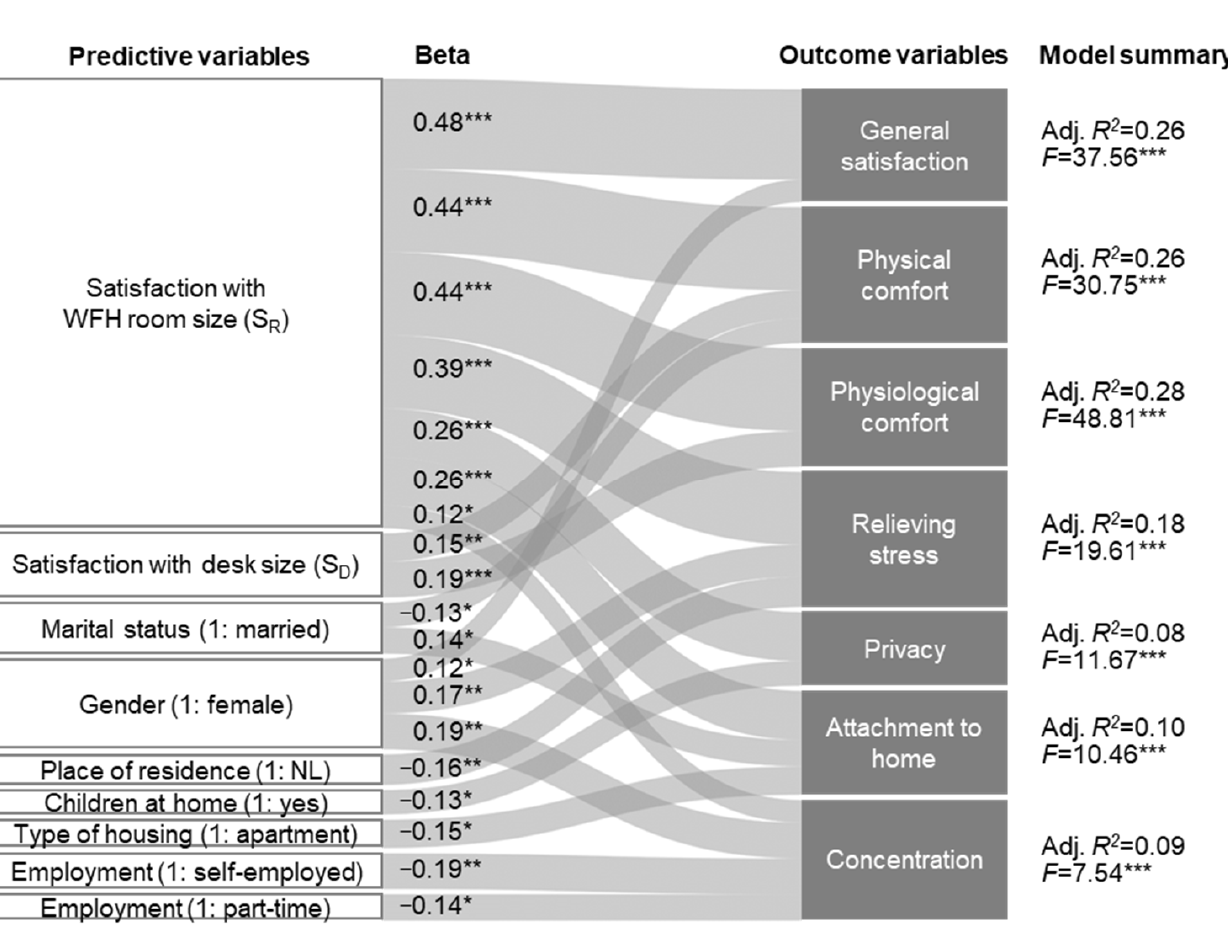
Figure 2. Regression models predicting ratings for home workspace (* p < 0.05, ** p < 0.01, *** p < 0.001).